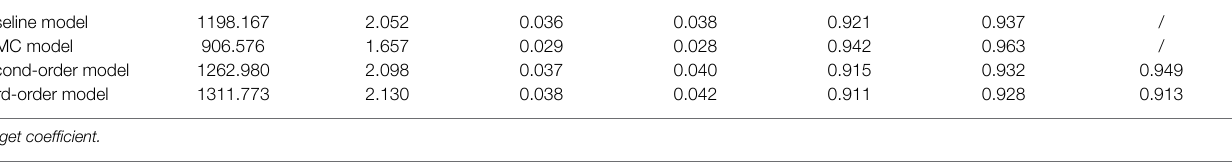
TABLE 8 | Correlation between PSCSTS and